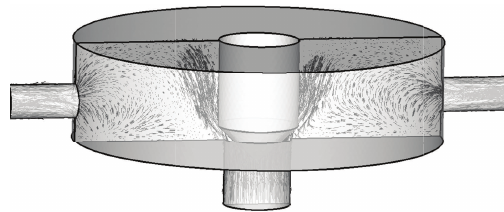
Figure 1: Velocity vector field and streamlines in meridional section plane.